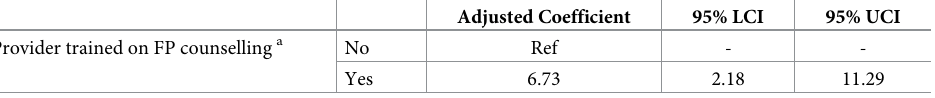
Table 4. Adjusted linear regression to test the association between Quality of FP Counselling (QFPC) and training of providers on FP counselling characteristics (N = 237). Adjusted Coefficient 95% LCI 95% UCI Provider trained on FP counselling a No Ref - - Yes 6.73